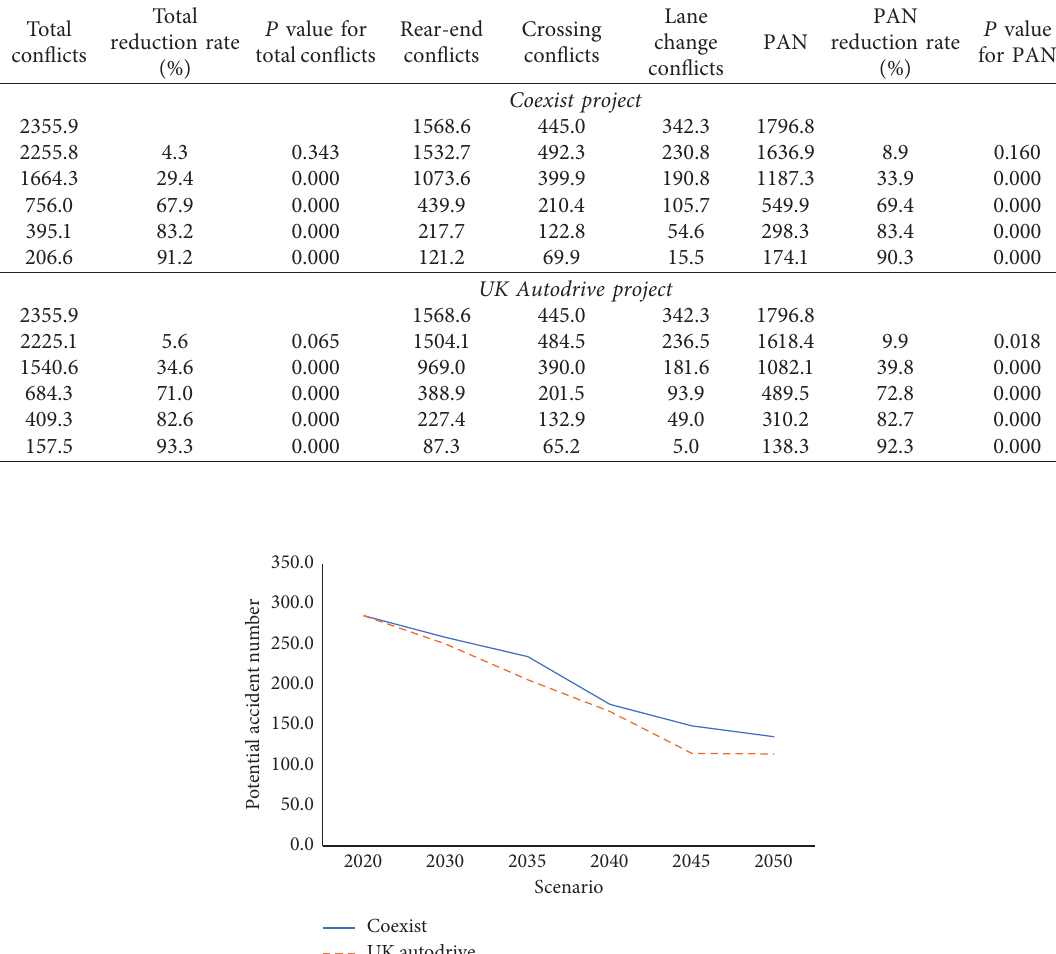
Table 6: Conflict results for Sattarkhan intersection with the real-world demand.